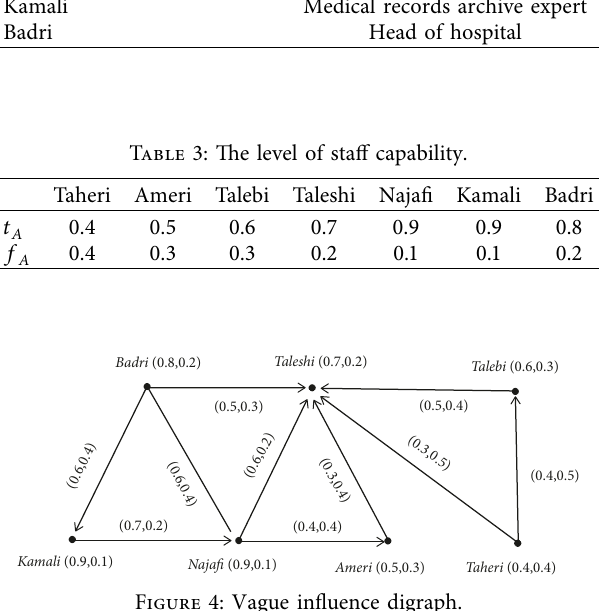
Figure 4: Vague influence digraph.